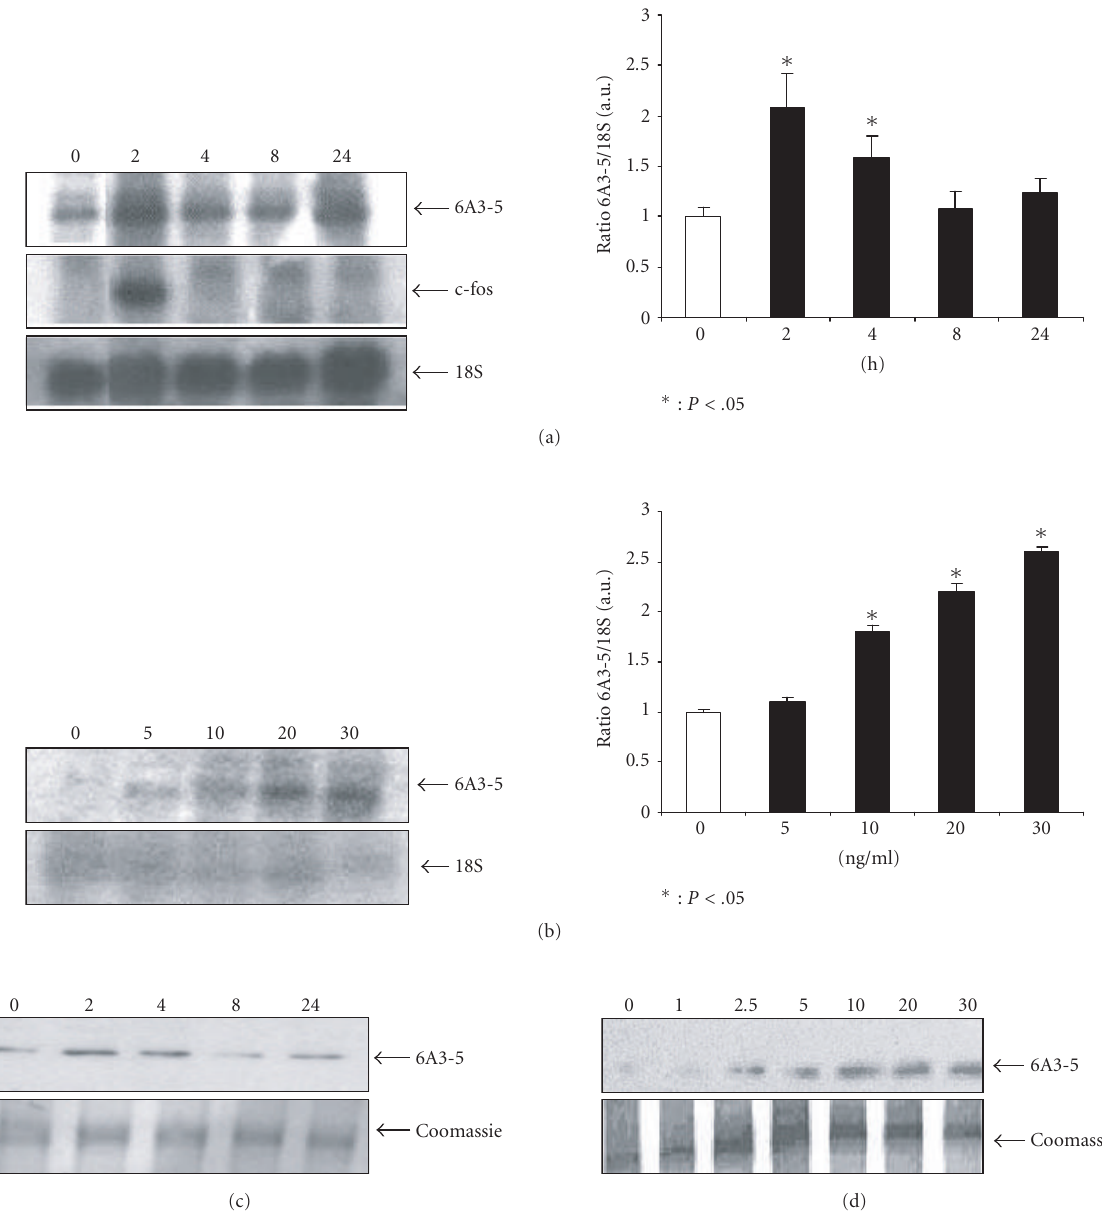
Figure 5: Time course and dose e ff ect of PDGF on 6A3-5/Osa2 expression . (a) Time course of 6A3-5/Osa2 mRNA level analysed by Northern- blot, following treatment of human proliferating VSMC (9th passage) with 20ng/ml PDGF. VSMC were serum starved for 48 hours before analysis. (b) Dose e ff ect of 6A3-5/Osa2 mRNA level analysed by Northern-blot, following treatment of VSMC with increasing concentrations of PDGF for 2 hours. (c) Time course of 6A3-5/Osa2 protein levels investigated by Western blot. (d) Dose e ff ect of 6A3-5/Osa2 protein levels investigated by Western blot, following VSMC treatment with increasing concentrations of PDGF for 4 hours. The results are representative of three independent experiments. Northern-blots were quantified by Quantity One tool (Bio-Rad) and normalized by 18 S rRNA level. Data are presented as means ± SEM . ∗ : P < . 05 versus nonstimulated control cells. The Coomassie blue-stained gel indicates equal protein